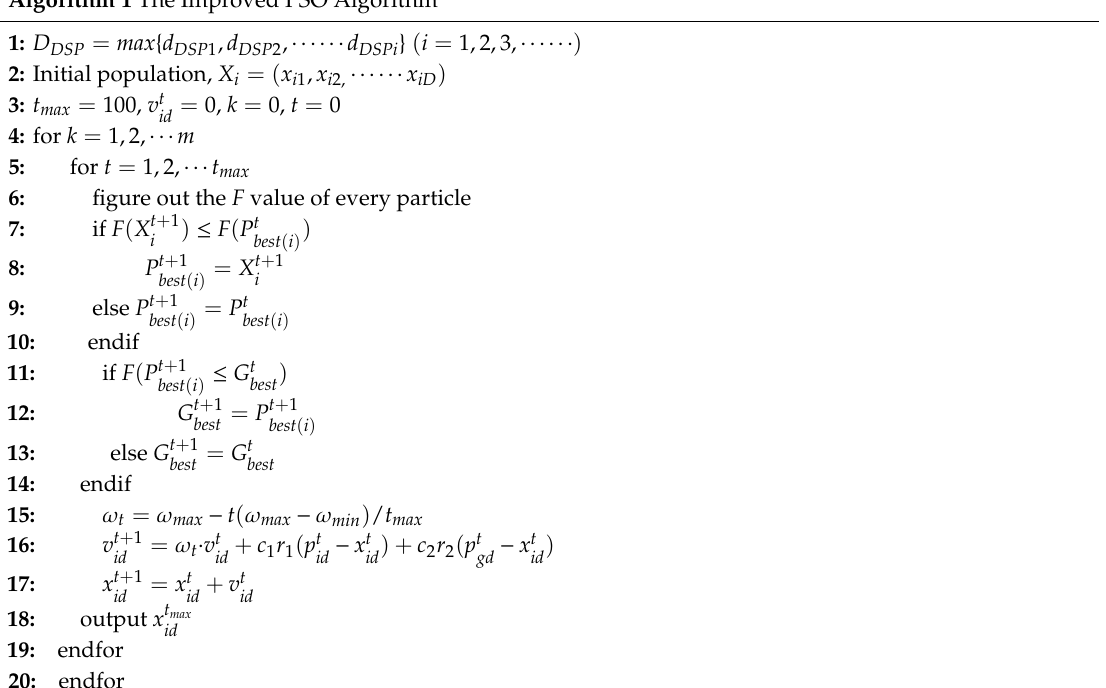
Algorithm 1 The Improved PSO